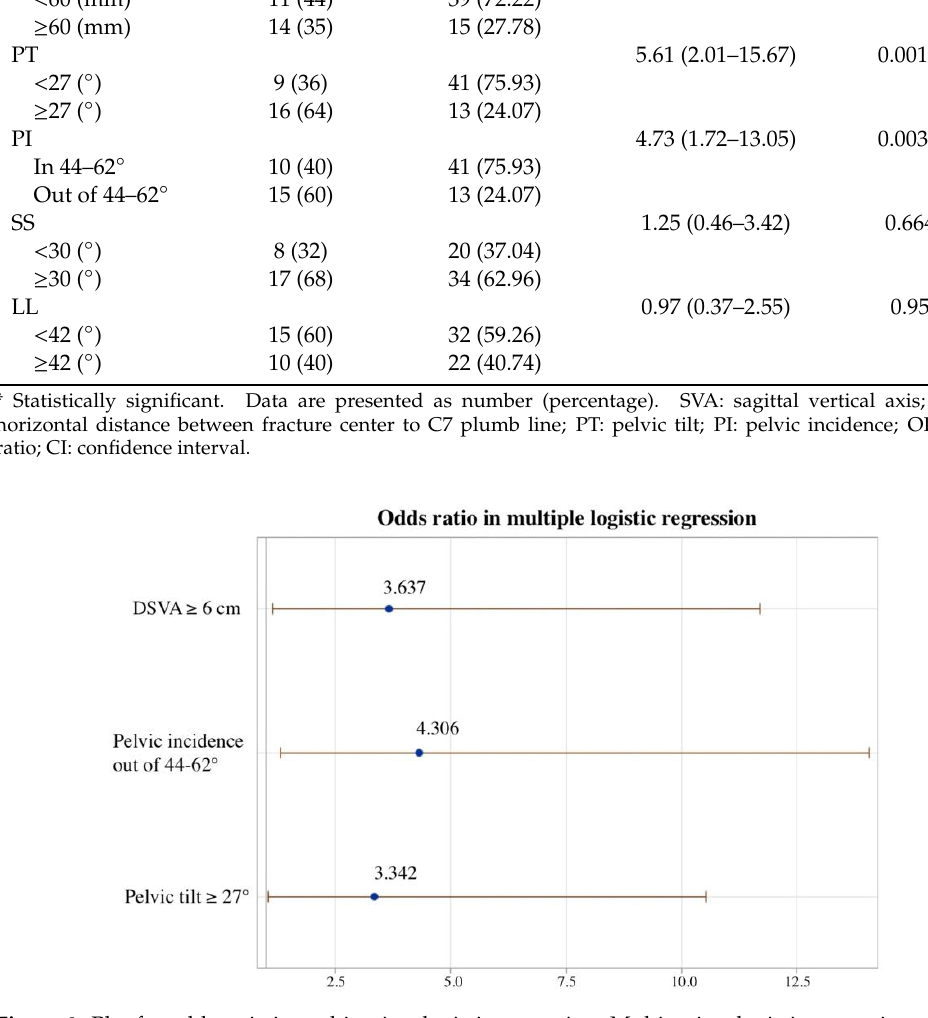
Figure 3. Plot for odds ratio in multivariate logistic regression. Multivariate logistic regression analysis found that PT > 27°, PI outside the range of 44° to 62°, and DSVA ≥ 6 cm (OR = 3.342, 4.306 and 3.637, respectively), were associated with failure of conservative treatment and the need for surgery.